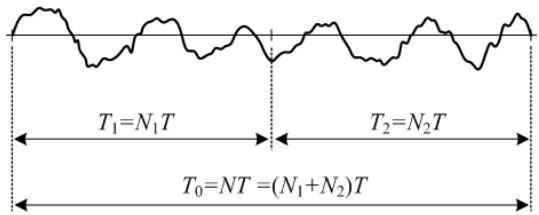
Figure 1. Sampling and number of data at multiple time intervals.